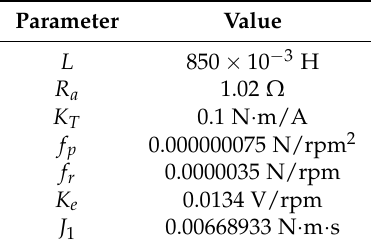
Table 1. Parameters of a DC